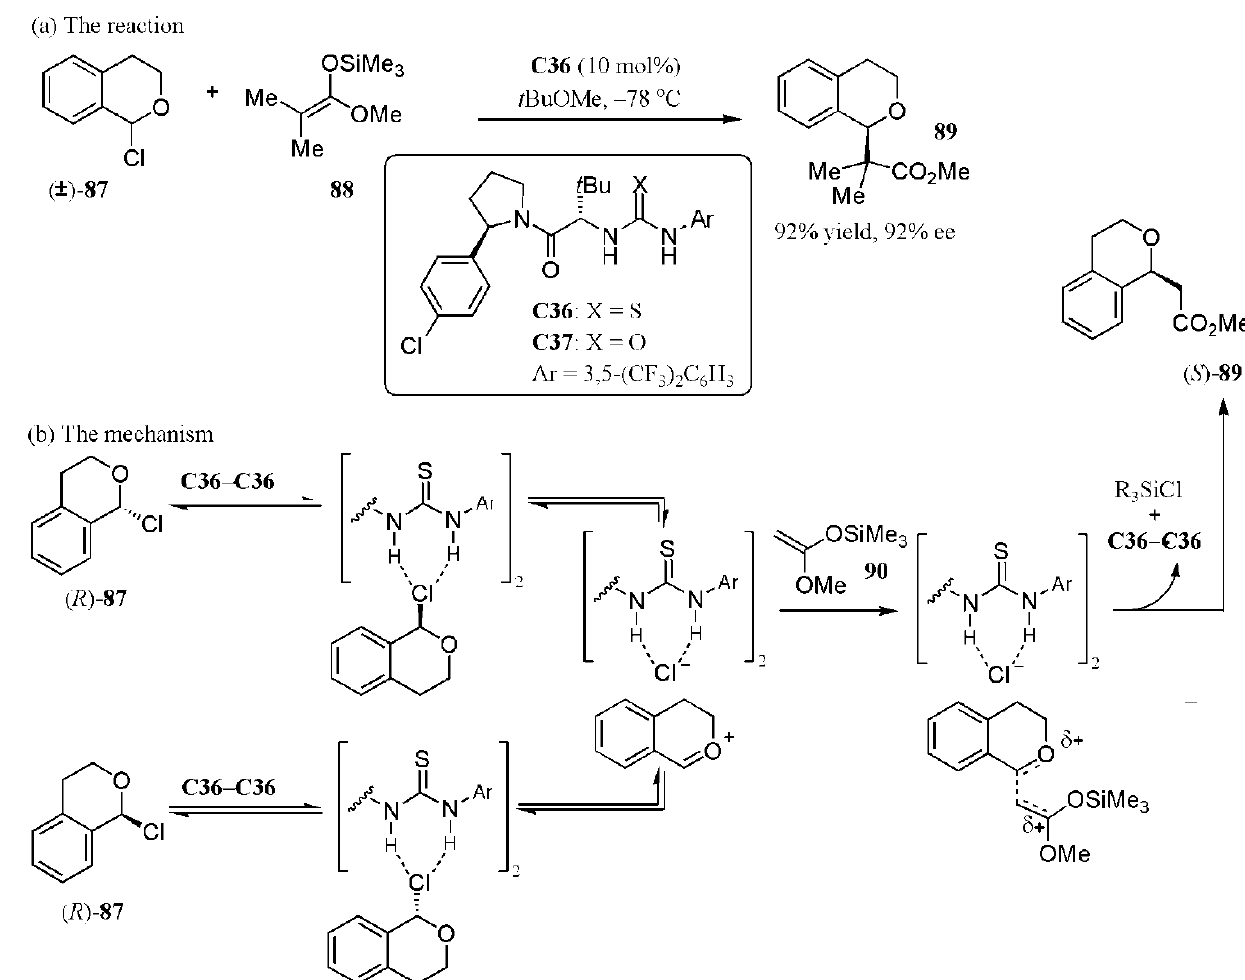
Figure 47. Enantioselective α -chloroisochroman alkylation via anion-abstraction catalysis ( a ) and its mechanism ( b ) [91].